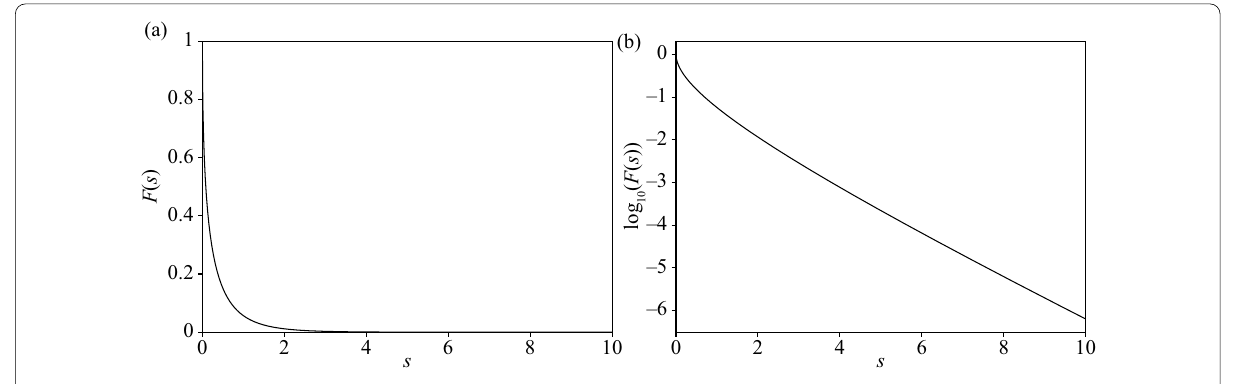
Fig. 2 Plots of a F ( s ) and b log 10 ( F ( s )) , which represent transition between undrained to drained